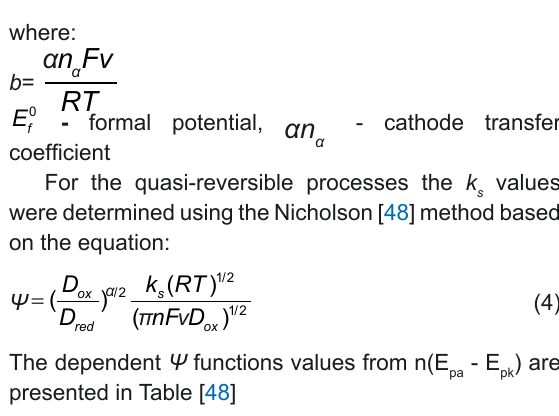
Figure 5. The cyclic voltammogram of 1×10 -3 mol dm -3 In(III) in 1 mol dm -3 NaClO mol dm -3 : 0 (•); 3×10 -4 ( ο ); 5×10 -4 ( ■ ); 8×10 -4 ( □